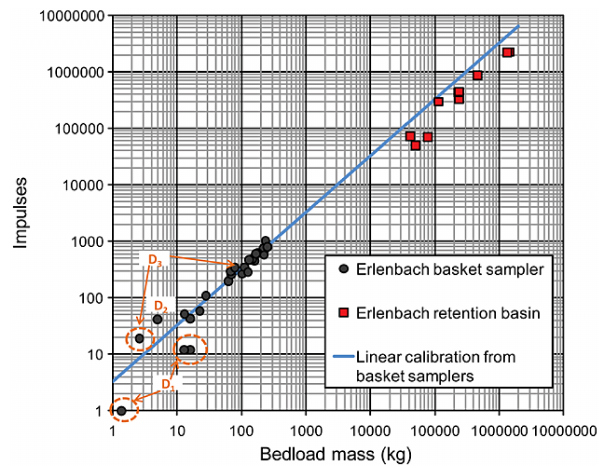
Figure 4. Comparison of calibration measurements of geophones and sediment transport from basket samplers (dots) and retention basin (squares) in the in the Erlenbach, Switzerland. After Rick- enmann et al. (2012). Group data labelled D 1 , D 2 , and D 3 denote less reliable data (outliers) for the geophone calibration (see Rick- enmann et al.,